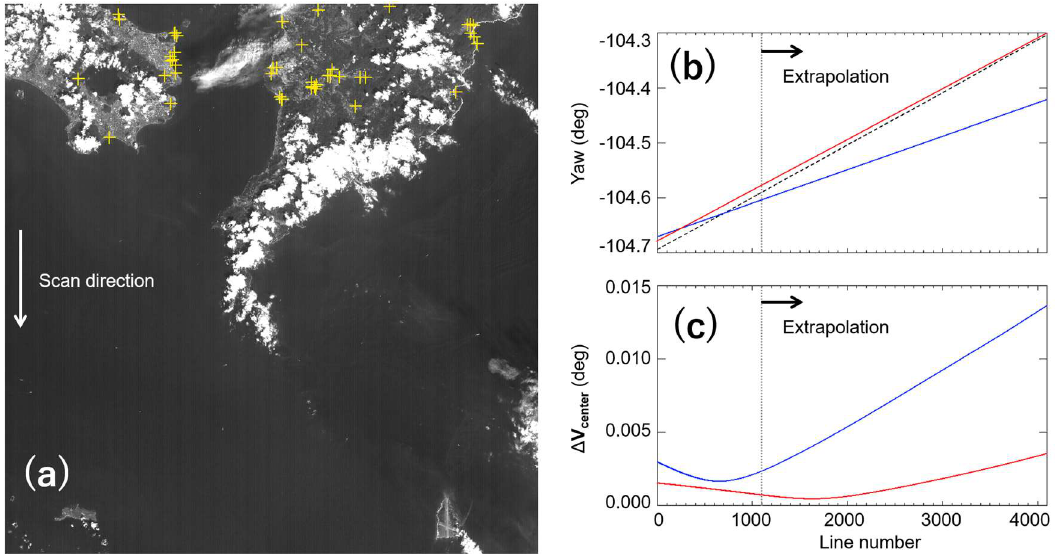
Figure 8. ( a ) ASTER L1A scene in which large part of scene was covered by sea. “+” denotes locations of matched features used for attitude determination. ( b ) Comparison of yaw angles derived from the proposed method using only one scene (blue solid), and sequential three scenes (red solid), and derived from onboard attitude sensors (dashed). ( c ) Differences in directions of line-of-sight vectors at the center pixel of ASTER between two attitudes derived from onboard attitude sensors and the proposed method using only one scene (blue line) and sequential three scenes (red line).